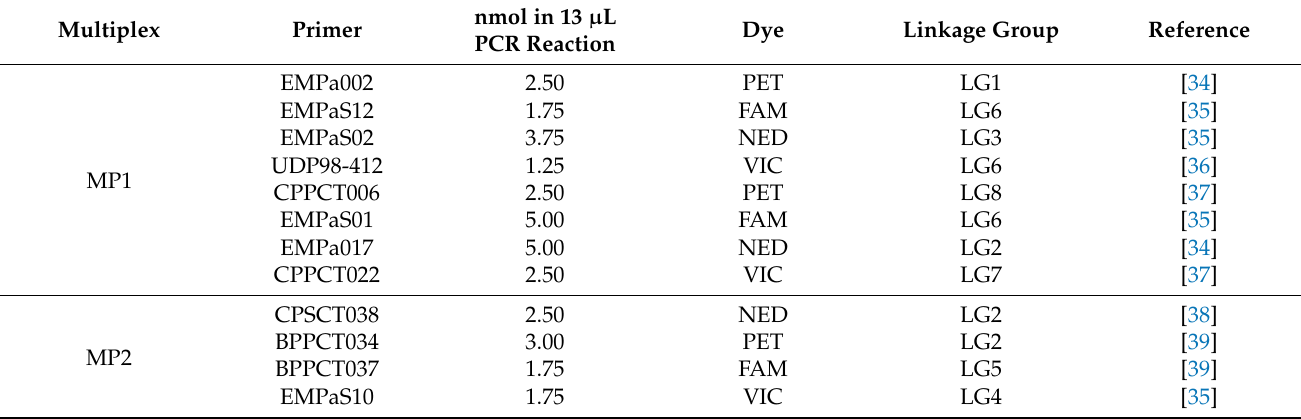
Table 3. Primers used for SSR-analysis in multiplex PCR